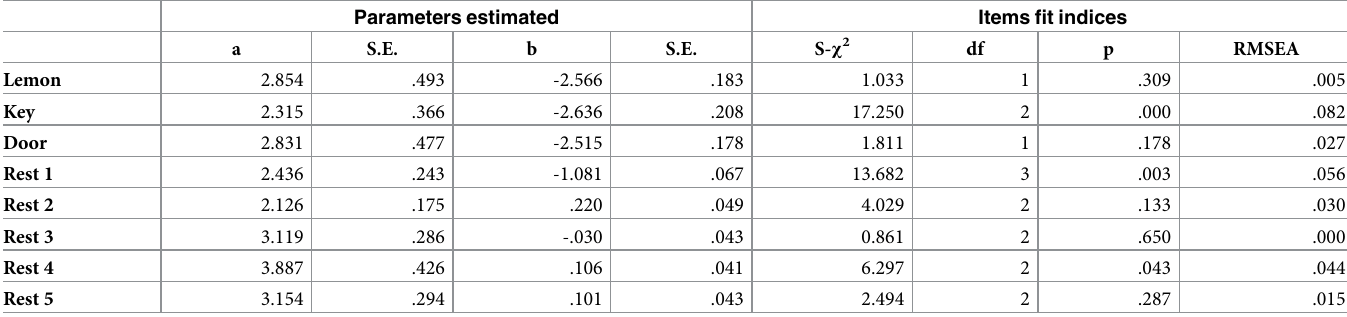
Table 4. Parameters estimated and item fit indices of attention